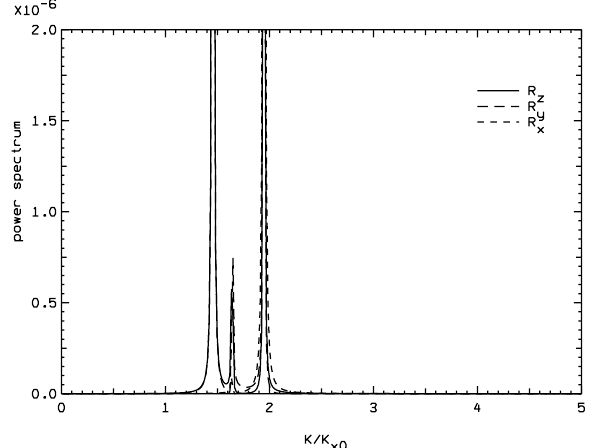
FIG. 4. The ratio between the wave number of particle synchrotron motion and the wave number of the high mode and the low mode as a function of